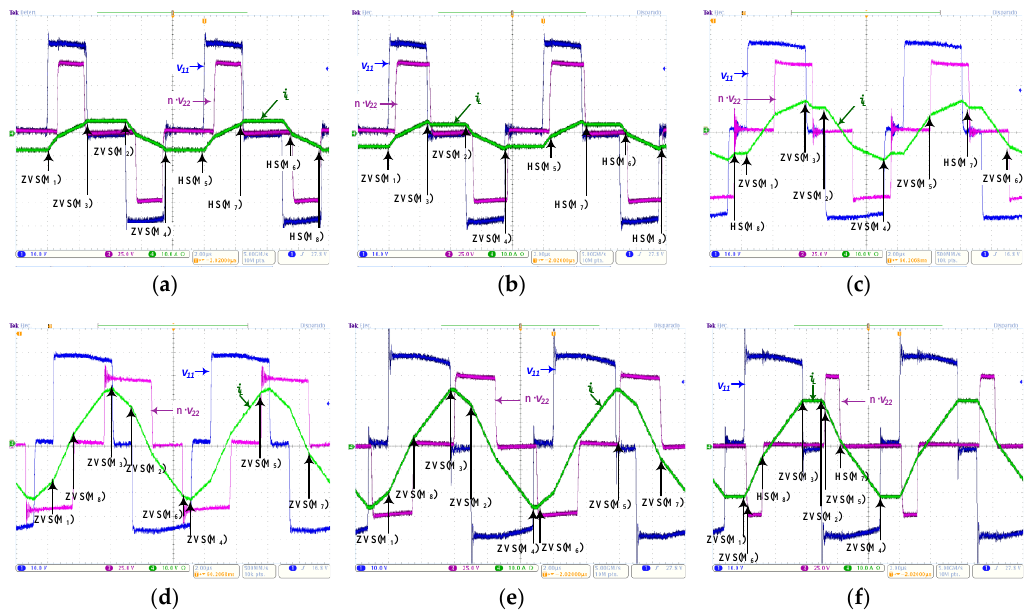
Figure 12. Switching modes for Case I: ( a ) SM 1 with HS in M 5 y M 6 ( φ / π < SS 56 ); ( b ) SM 2 with HS in M 5 y M 6 ( φ / π < SS 56 ); ( c ) SM 2 * with ZVS in M 5 y M 6 ( φ / π > SS 56 ); ( d ) SM 3 * with ZVS in M 7 y M 8 ( φ / π > SS 78 ); ( e ) SM 4 with ZVS in M 7 y M 8 ( φ / π > SS 78 ); and ( f ) SM 5 with HS in M 7 y M 8 ( φ / π < SS 78 ).